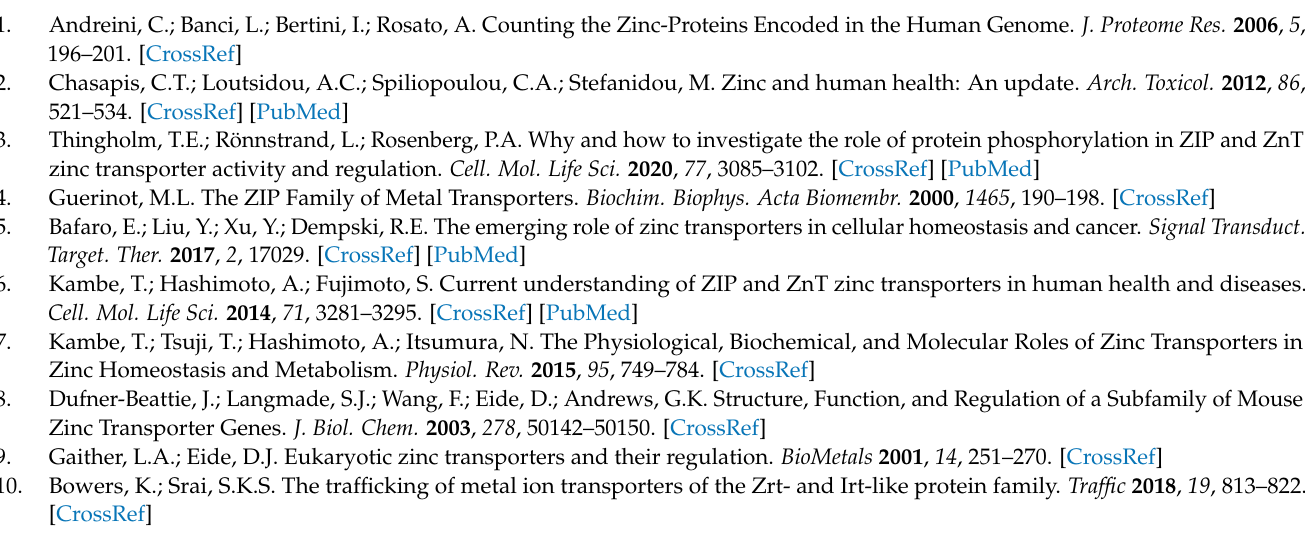
Figure S2: Detergent screening of N-terminal hZIP1 fusions, Figure S3: Cleavage of His-TEV-hZIP1 fusion with tobacco etch virus (TEV)